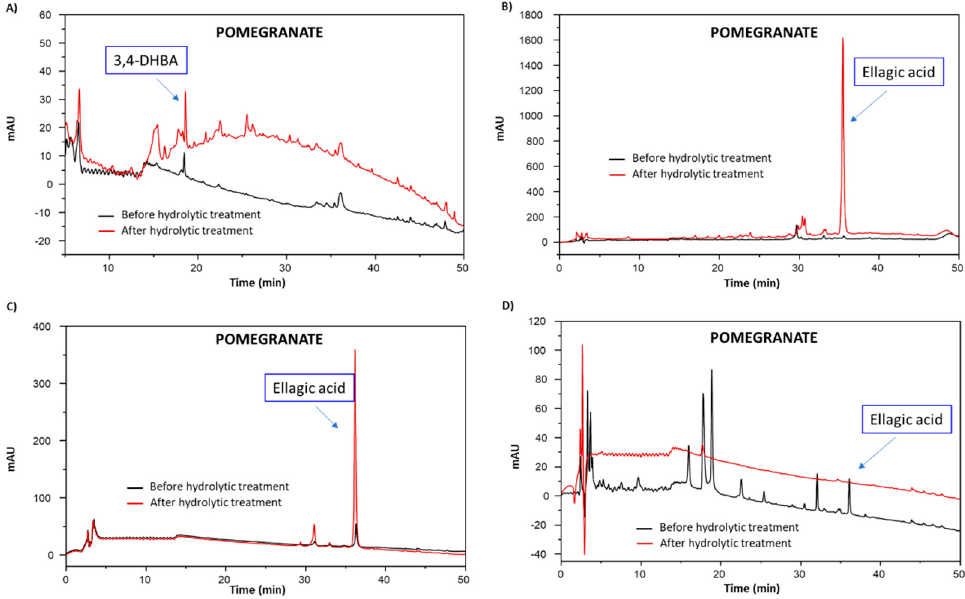
Figure 11. HPLC elution profiles of the chemical degradation mixtures of pomegranate. ( A ) Alkaline hydrogen peroxide degradation mixture. ( B ) Alkali fusion mixture. ( C ) Solid residue from the acid degradation mixture. ( D ) Supernatant from the acid degradation mixture.